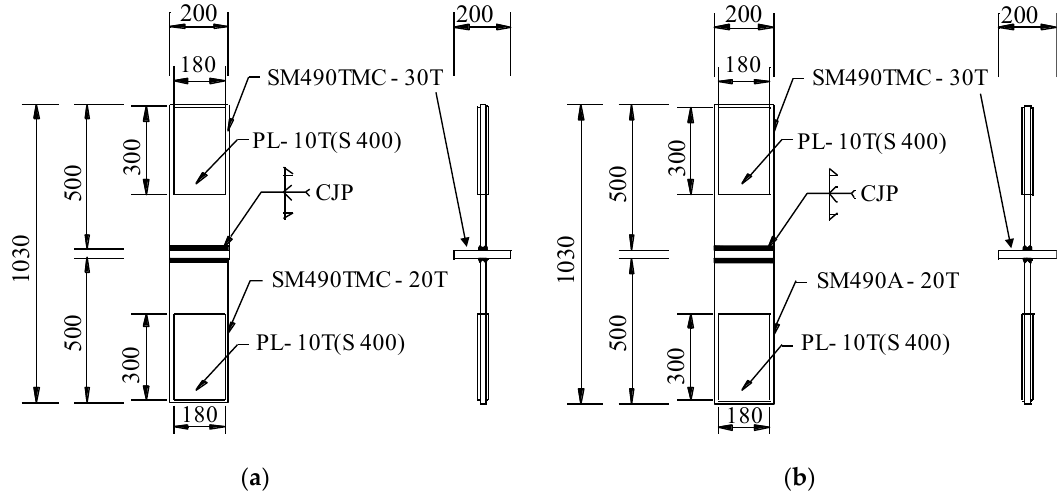
Figure 4. Specimens for direct tensile test at welding joint. ( a ) SM490TMC-30T and SM490TMC-20T; ( b ) SM490TMC-30T and SM490A-20T.